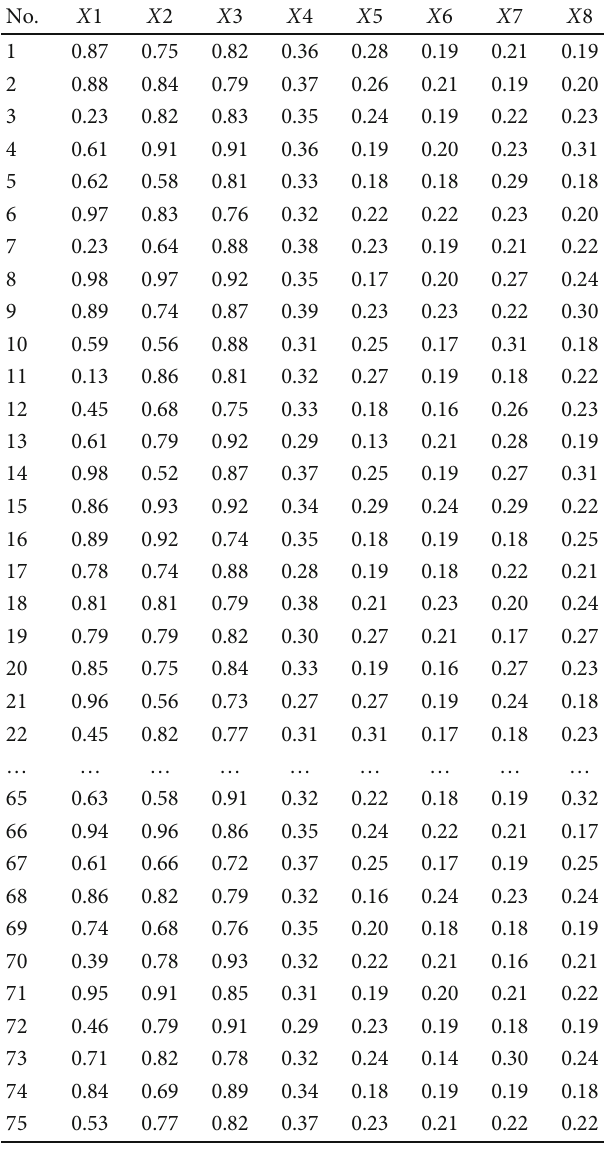
Table 4: Sequence of physiological factors after data